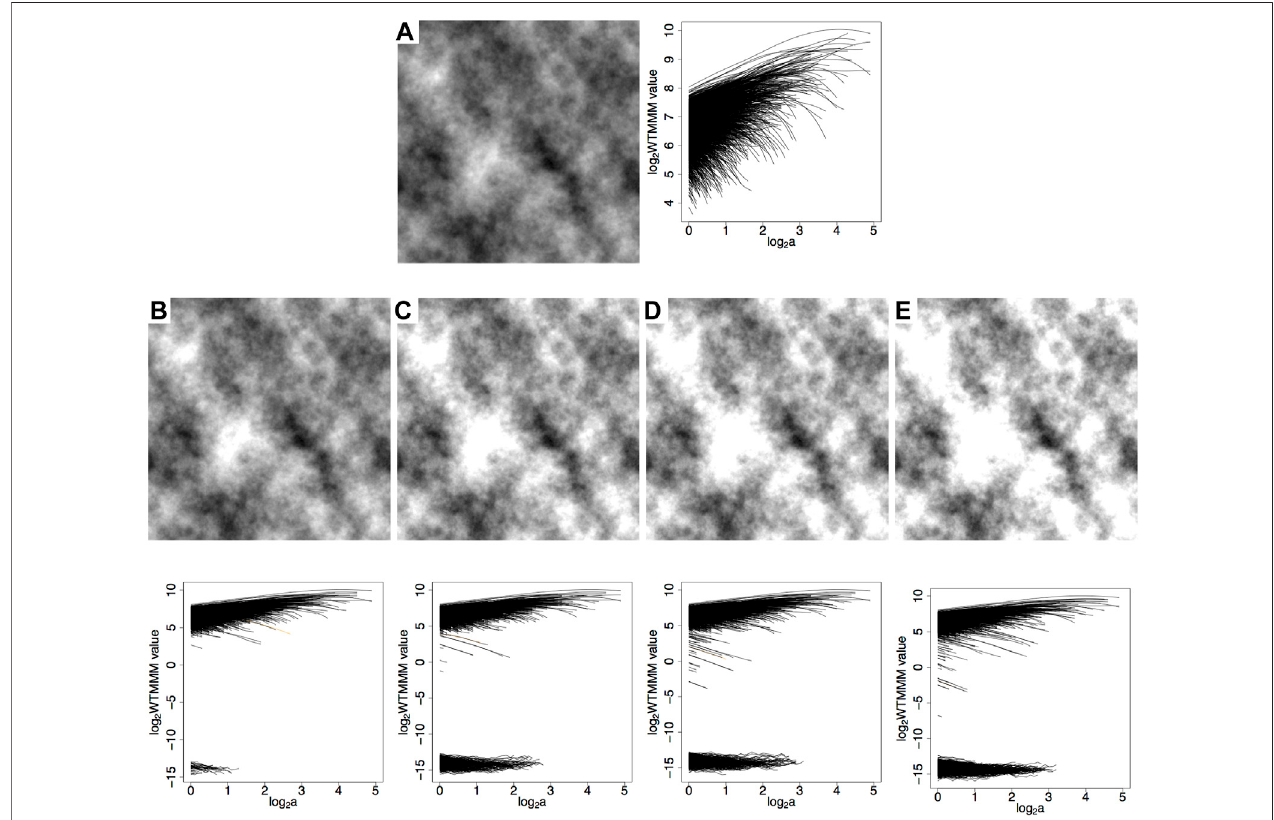
FIGURE 5 | (A) A sample fBm surface with H = 0.7 and its corresponding sheaf (right). (B) The same fBm surface as in (A) but saturated at 1% and the corresponding sheaf directly below. (C – E) Saturated fBms at (C) 5%, (D) 10%, and (E) 20% and sheafs below. Maxima lines associated with extremely low modulus values,and otherswith anoverall negative slope, appear inhigher numbers withincreasingsaturation. Theseextraneousmaximalines willinterferewith h ( a , q ) and D ( a , q ) calculations, which then reduces the number of statistical order moments as shown Figure 6 .